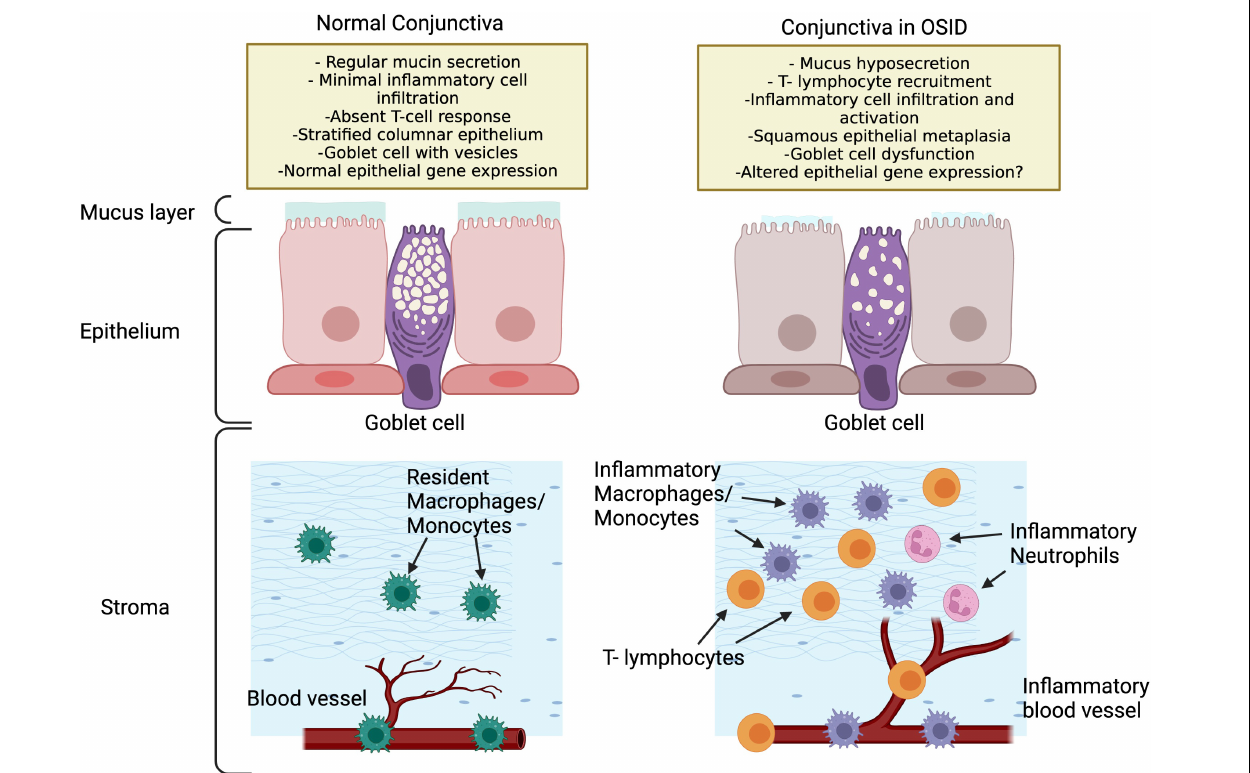
FIGURE 2 | Potential conjunctival changes in OSID that lead to ocular dryness and increased inflammation. Note that the OSID impact the conjunctiva in many ways that are not fully